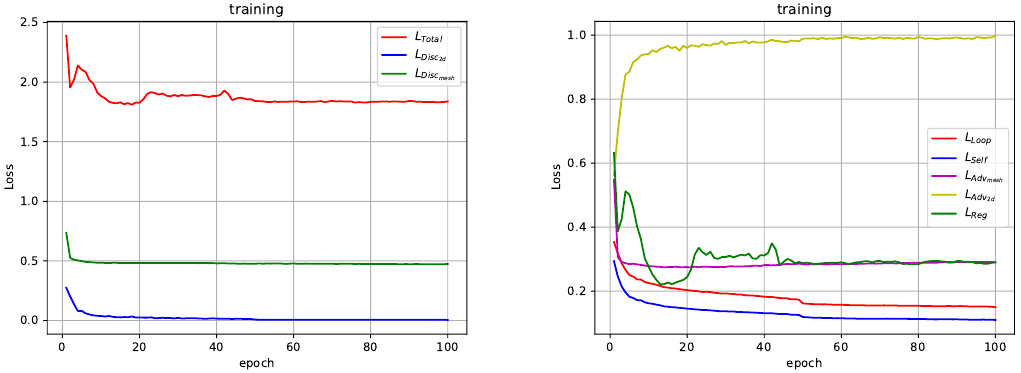
Figure 5. Curves of all our losses during training.